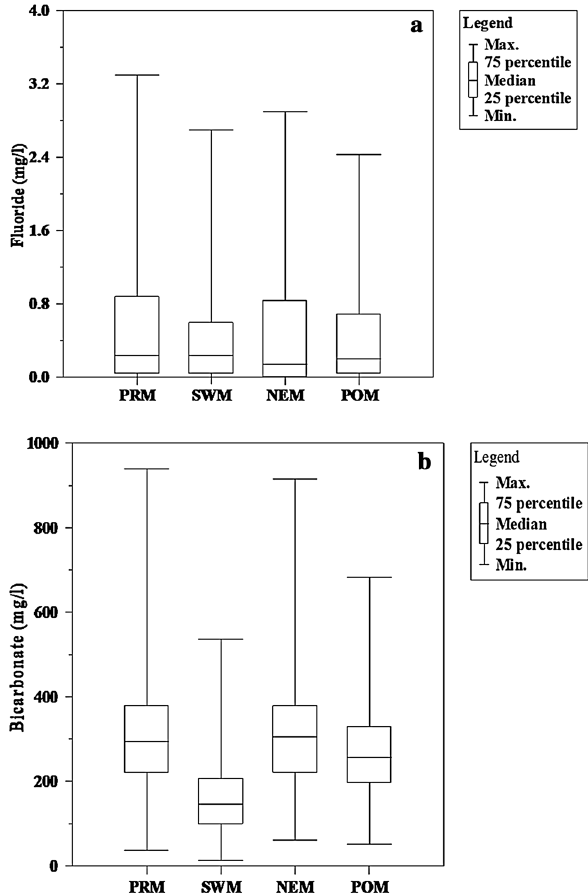
Fig. 2 Box plot for the maximum, minimum, and average of the chemical constituents in groundwater during PRM and POM (all val- ues in mg l −1 except